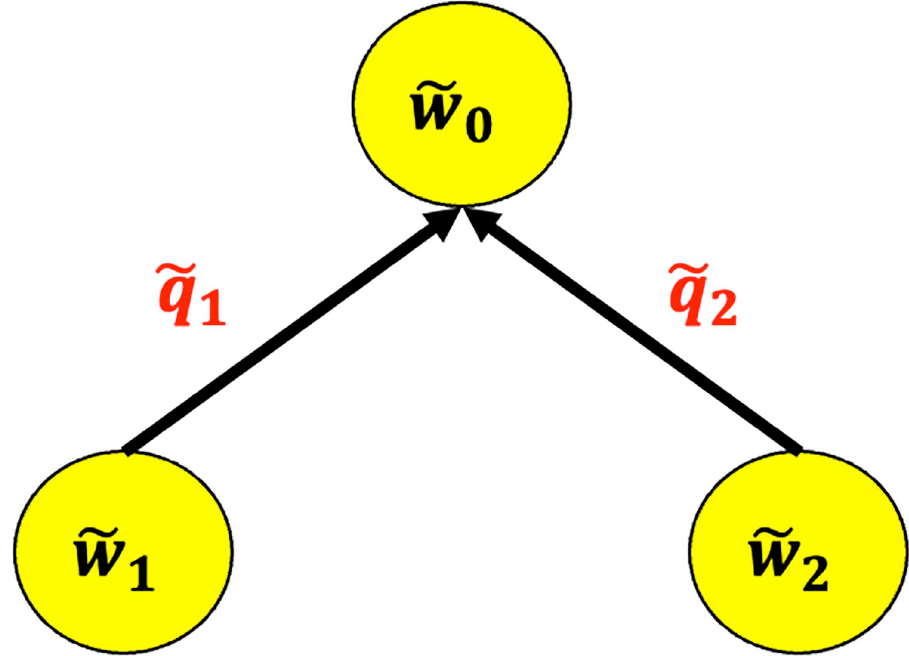
Fig 1. A structure of a star graph G ? having one junction node and two edges.